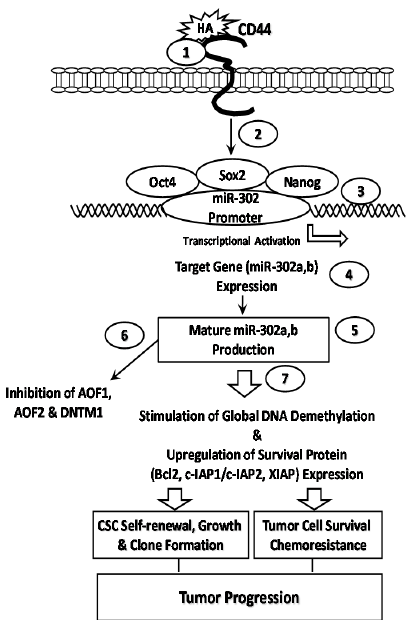
Figure 4. HA-CD44 interaction promotes miRNA-302 expression and chemoresistance: In cancer stem cell (CSC) signaling, the binding of HA to CD44 (step 1) stimulates Nanog, Oct4, and Sox2 complex formation with CD44v3 (step 2) . This Nanog-Oct4-Sox2 signaling complex then interacts with the promoter region (containing Nanog, Oct4 and Sox2-binding sites) of the miR-302 cluster (step 3) resulting in miR-302 cluster gene expression (step 4) and mature miR-302a and miR-302b production (step 5) . The resultant miR-302 then downregulates the lysine-specific histone demethylases (namely AOF1 and AOF2) and DNA (cytosine-5)-methyltransferase 1 (DNMT1) (step 6) and induces global DNA demethylation (step 7) leading to IAP (cIAP-1, cIAP-2, and XIAP) expression, self-renewal, clonal formation, anti-apoptosis/survival, and chemoresistance in CSC-like CD44v3 high ALDH1 high cells. All these events participate in cancer progression.